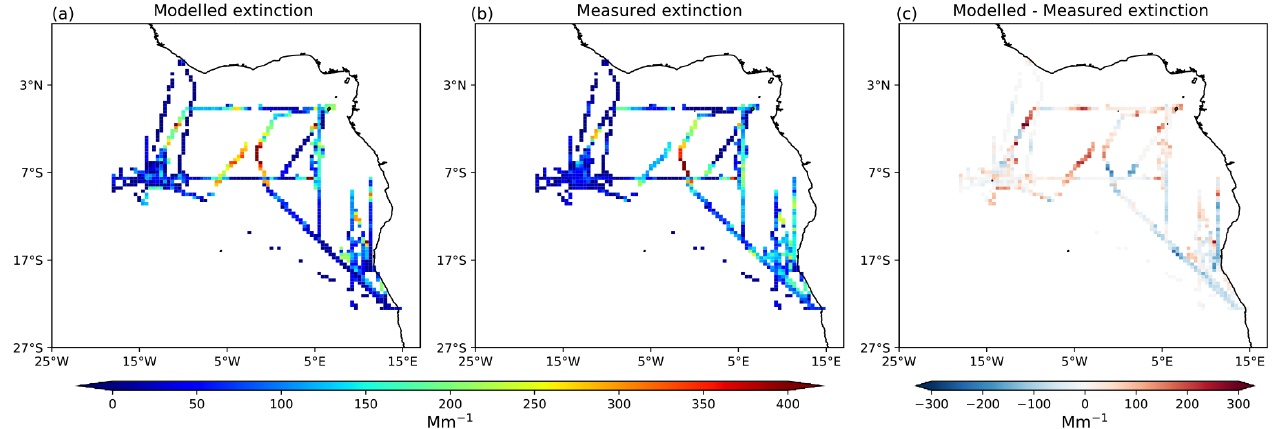
Figure 1. Mean along-track aerosol extinction coefficient (Mm − 1 ) from the (a) UKESM1 model collocated to the flight tracks, (b) flight observations, and (c) differences between the model and observations. Note that the model extinction is under ambient conditions, whereas the measured extinction is for dry aerosols with relative humidity below 30%.